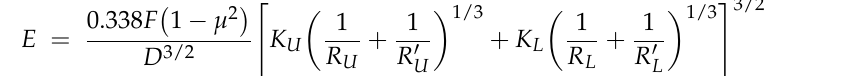
where E is the apparent modulus of elasticity, Pa, D is the strain, m, µ is the Poisson coefficient, F is the strain causing force, N, R U is the minimal grain curve radius in the point of contact with the upper horizontal plate, R U (cid:48) is the maximal grain curve radius in the point of contact with the upper horizontal plate, R L is the minimal grain curve radius in the point of contact with the lower horizontal plate, R L (cid:48) is the maximal grain curve radius in the point of contact with the lower horizontal plate, and K U , K L are the constants resulting from the curve of grain being in contact with the